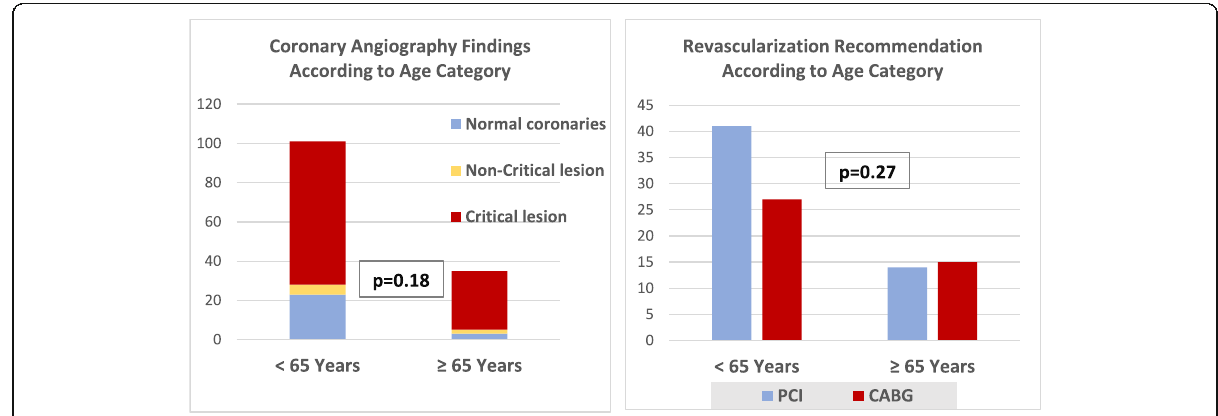
Fig. 3 Coronary angiography findings and revascularization recommendation in NSTE-ACS according to age category. Among total patients referred for catheterization ( n = 139), catheterization records were missed in 3 patients (1 in age < 65 years and 2 in older